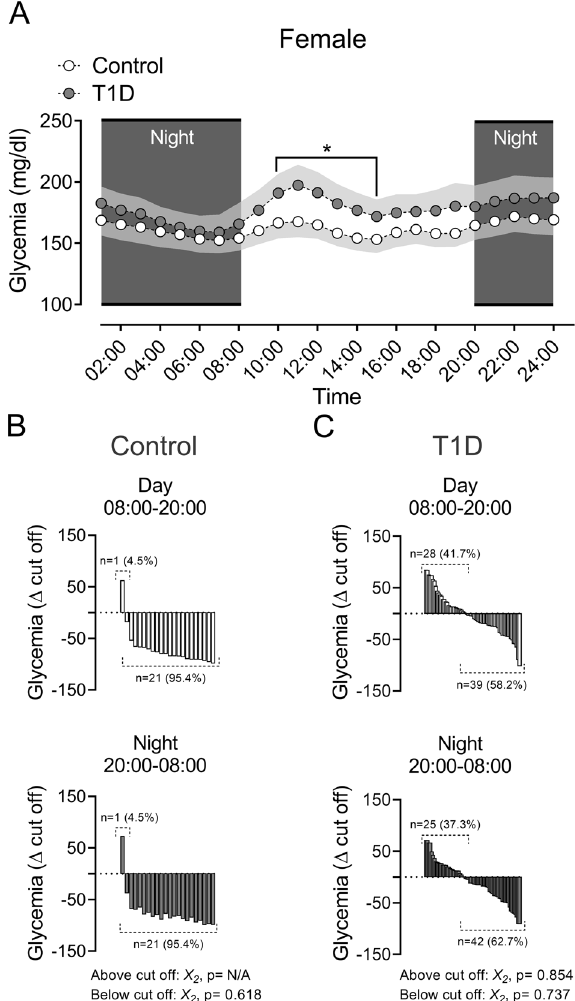
Figure 4. Circadian rhythm of glycemia and magnitude of hyperglycemia and euglycemia events during day and night phases in females T1D and control participant. ( A ) During day phase, females with T1D showed a significant difference compared to their matched control group between 10:00 to 15:00. (Two ways ANOVA, following Fisher posthoc; F (DFn: 2, DFd: 119) = 3.91; p = 0.022). ( B , C ) magnitude of hyperglycemias and euglycemia’s during day and night phases, in Control and T1D female patients, respectively. There are no significant differences between all